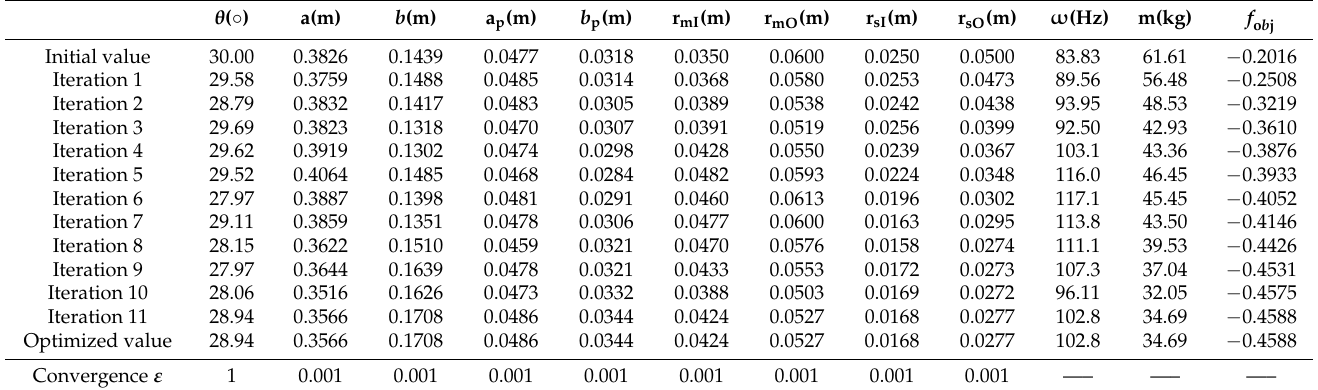
Table 3. Design parameters and objective functions in the optimization